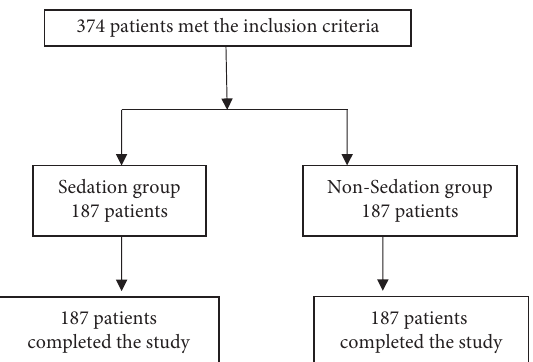
Figure 1: Consort diagram showing patient allocation to two